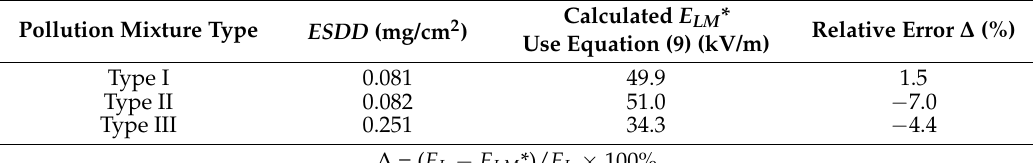
Table 11. Flashover voltage gradient correction, considering the slight solubility of CaSO 4 .